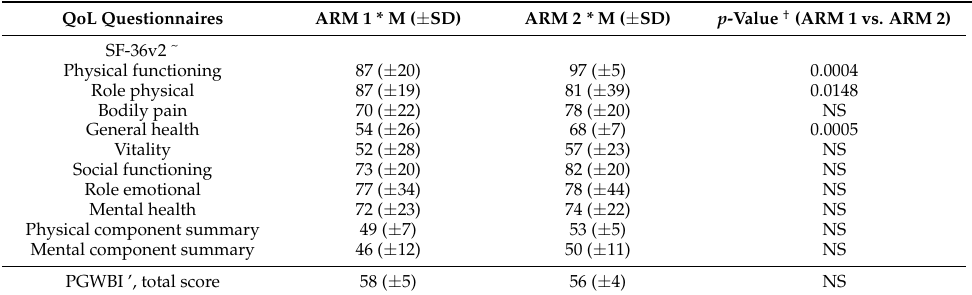
Table 3. Results of the QoL questionnaires at baseline.